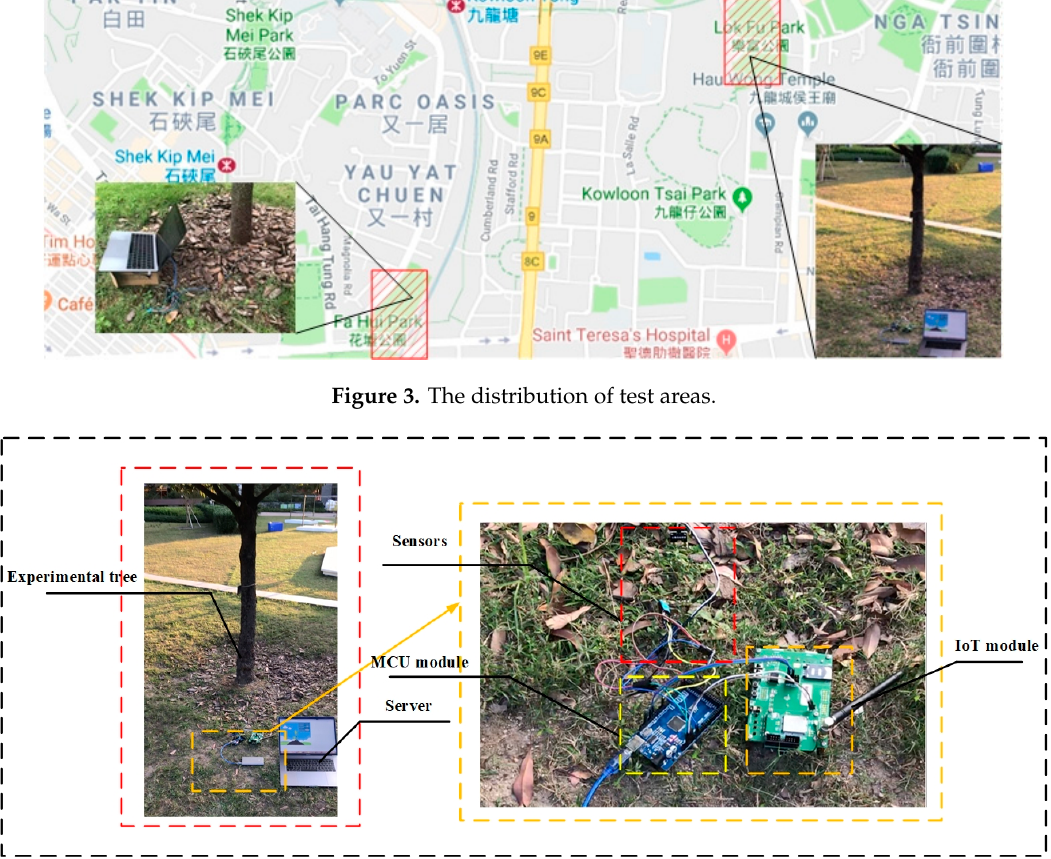
Figure 4. The experimental scene. Table 2. Health distribution of samples.